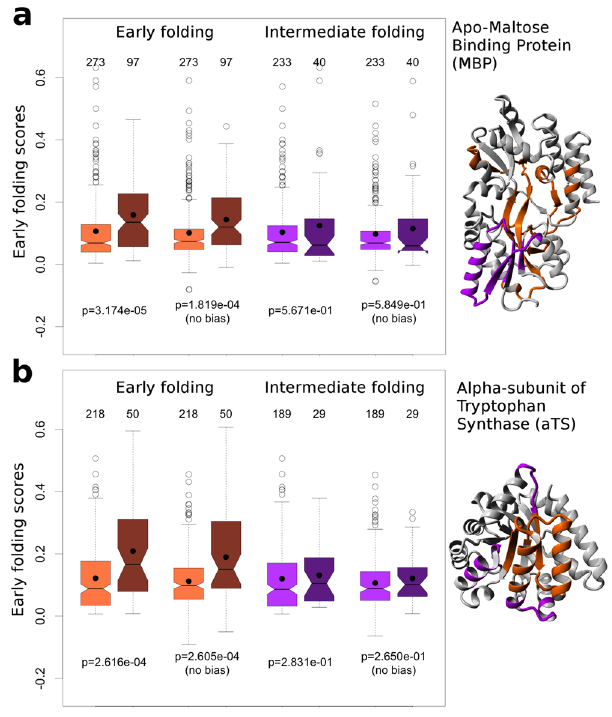
Figure 3. The distribution of the EFoldMine predictions separated by residues experimentally identified by HDX Mass Spectrometry (MS). ( a ) Apo-Maltose binding protein and ( b ) the alpha subunit of tryptophan synthase. The separation by MS data for early (brown) and intermediate (purple) folding residues is shown, with the experimentally identified residues in dark shade, the remaining residues in light shade, and with the amino acid bias-corrected distributions included (no bias). The number of data points is indicated above each distribution, the p-value of the significance of the difference between two distributions below the compared distributions. The protein structures show the early folding (brown) and intermediate folding (purple)